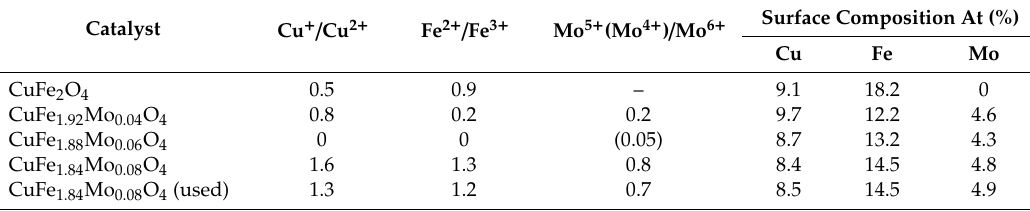
Table 2. Surface composition estimated from